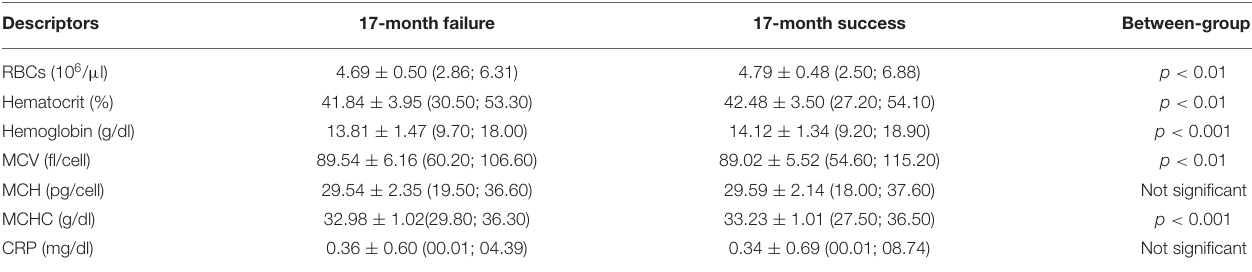
TABLE 4 | Baseline differences in biochemical parameters according to the long-term